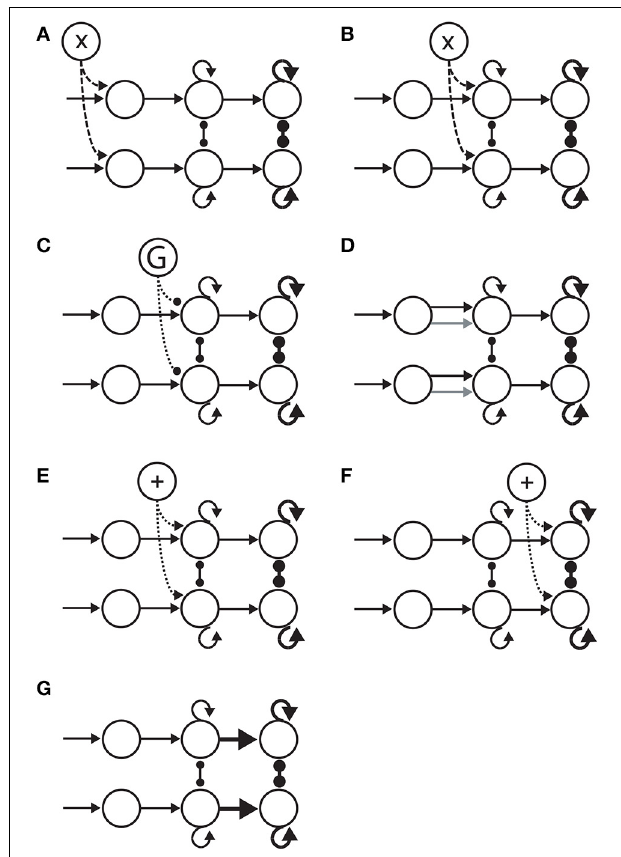
FIGURE 5 | Hypotheses on the neural implementation of the SAT, under the framework of bounded integration. Each panel is an instance of the 3-stage schematic in Figure 4 . (A) Modulation of the encoding of evidence. A cognitive signal adjusts the gain of sensory encoding populations (dashed arcs). This multiplicative effect is depicted by the “X” in the open circle at the top. (B) Modulation of the rate of integration of encoded evidence (dashed arcs). The cognitive signal adjusts the gain of integrator circuitry, controlling the rate of integration. (C) Modulation of the onset of integration of encoded evidence. An inhibitory gate (G) controls the onset of integration (dotted arcs). (D) Modulation of the sensitivity of integrator circuitry to encoded evidence. Integrator populations are selective for different sub-populations of evidence-encoding neurons under speed and accuracy conditions, depicted by the black (speed) and gray (accuracy) arcs. (E) Modulation of the amount of non-evidence input to integrator circuitry. All integrator populations receive a uniform cognitive signal, in addition ( + ) to evidence (dotted arcs). (F) Modulation of the amount of non-integrator input to thresholding circuitry. Neural populations enacting choice behavior receive a uniform cognitive signal, in addition ( + ) to integrated evidence (dotted arcs). (G) Modulation of the connectivity between integrator circuitry and thresholding circuitry. The amount of integrated evidence sufficient to make a choice is modulated by the strength of connectivity from integrators to the circuitry enacting choice behavior (thick horizontal